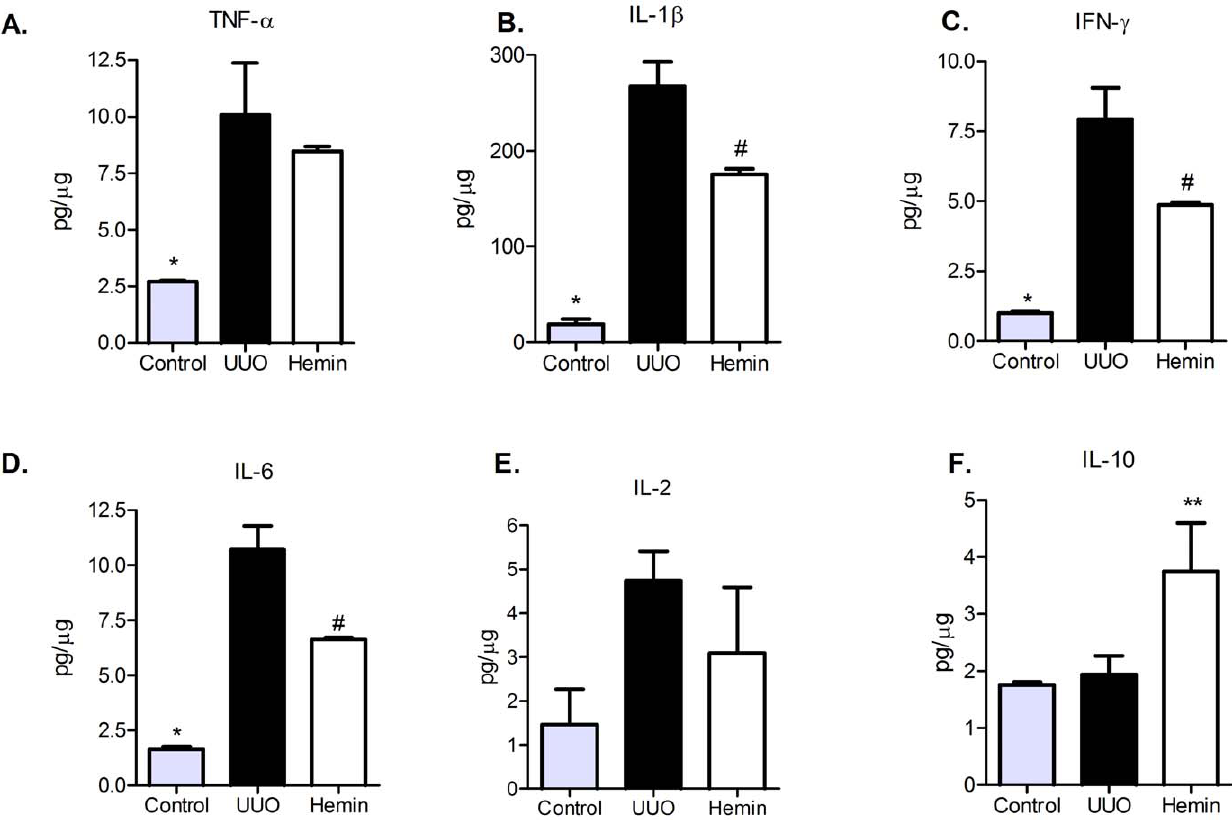
Figure 5. Hemin treatment leads to a decreased kidney protein expression (average ± s.e.m.) of TNF- a (panel A), IL-1 b (panel B), IFN- c (panel C), IL-6 (panel D) and IL-2 (panel E) and enhanced protein expression of IL-10 (panel F). * p , 0,05 vs UUO and Hemin, # p , 0,05 vs UUO and ** p , 0,05 vs control and UUO.